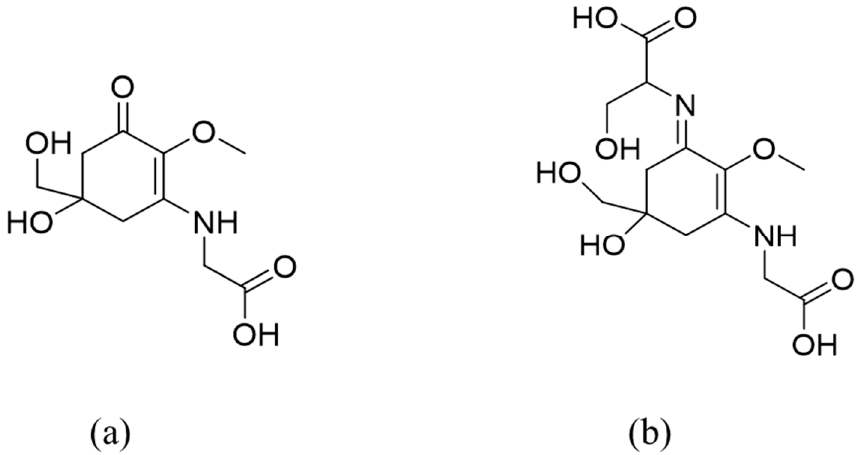
Figure 1. Examples of mycosporine-like amino-acids (MAAs) structures: ( a ) mycosporine-glycine (oxo-mycosporine); ( b ) shinorine (oxo-mycosporine); ( b ) shinorine (imino-mycosporine).